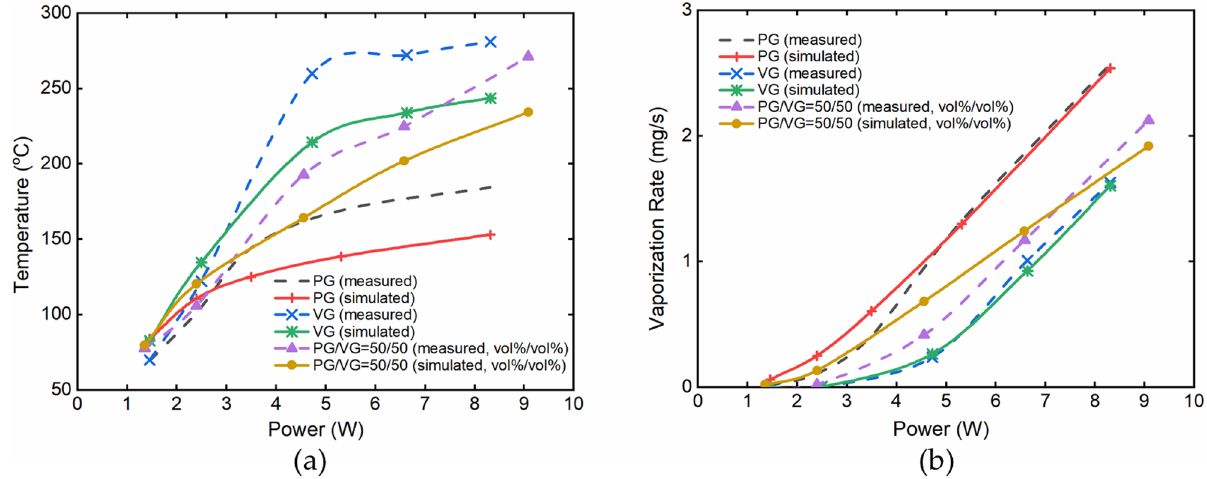
Figure 1. Correlations between applied electrical power and ( a ) liquid temperature, ( b ) vaporization rate at the condition of 100% PG, 100%VG, and PG/VG = 50/50 (vol%/vol%), 0.44 porosity. Puffing regime used: 3 s puff duration, 30 s puff interval and 55 mL puff volume, a square-wave puffing